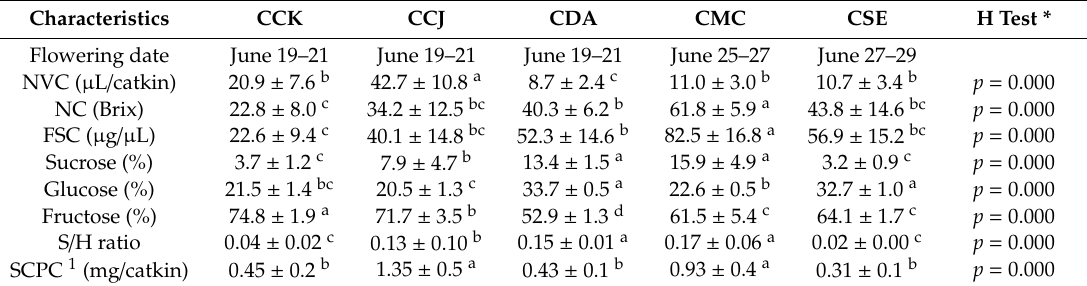
Table 1. Comparison to nectar volume, free sugar content, composition of sugar, and sugar content per catkin in floral nectar of Castanea